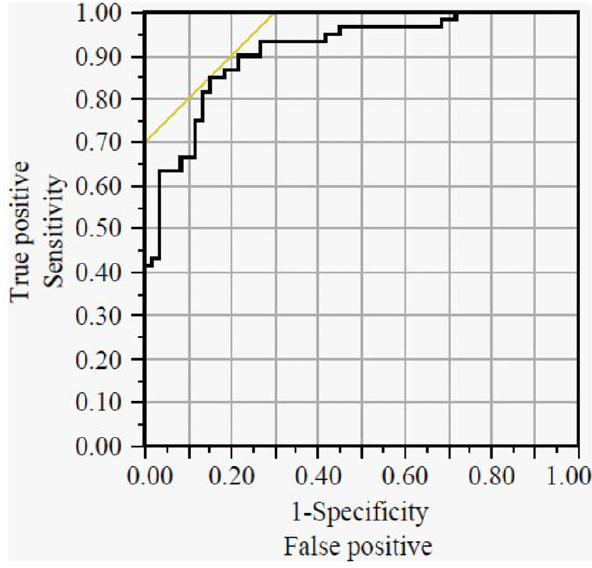
Figure 2. ROC curve of the established prediction model. The solid curve is the ROC curve for the prediction model established on the basis of the training set. The AUC and cut-off values were 0.9097 {95% confidence interval (95% CI): 0.8438–0.9495} and 0.4945, respectively. The sensitivity, specificity, and accuracy of this model are summarized in Table